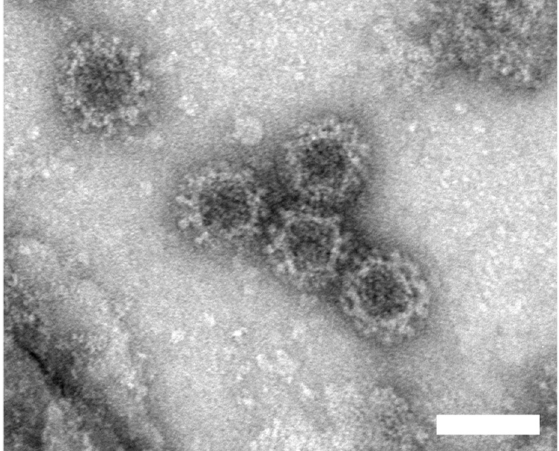
Figure 4. Electron micrographs of purified norovirus VLPs (scale bar: 50 nm).